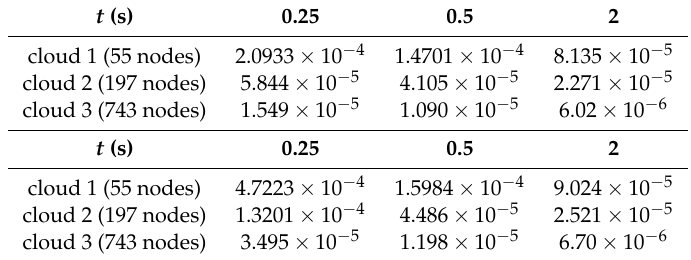
Table 2. l 2 and l ∞ norms of the errors of the imaginary parts,